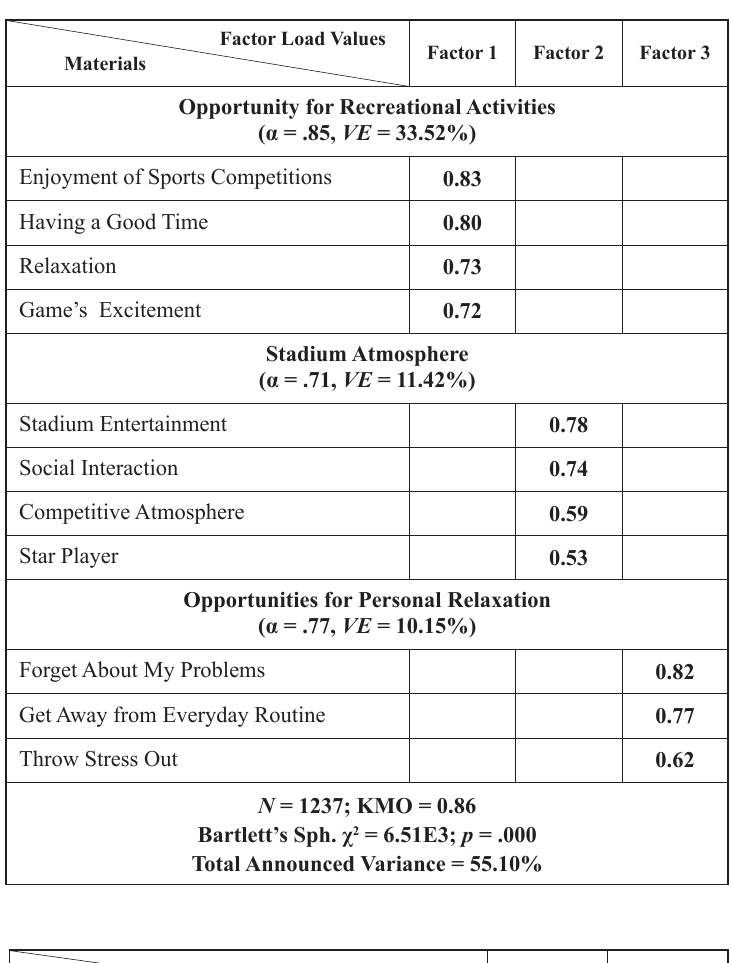
Table 5. Reasons of Super League Football Team Fans Attendance in the Stadium Scale factor analysis and load values